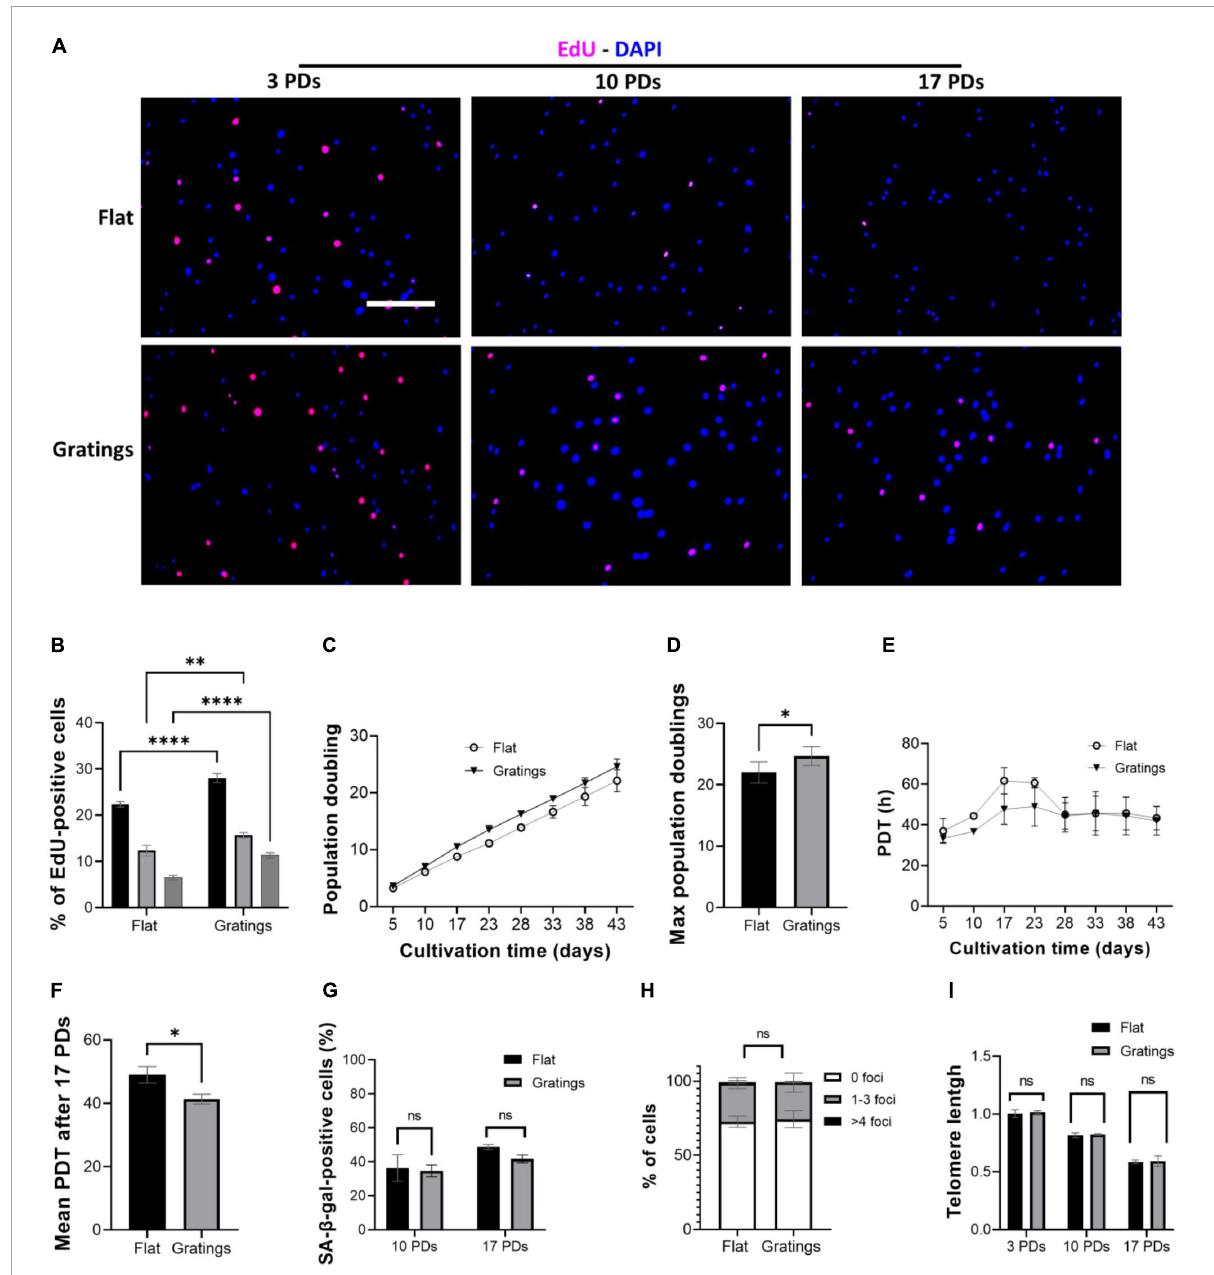
FIGURE6 Gratings increase HUVEC proliferation without inducing an early onset of senescence or DNA damage. (A) EdU proliferation assay with cells after 3, 10, and 17 PDs, which were cultured on a flat surface (upper panel) or on a surface with gratings (lower panel). Blue, DAPI; Red, EdU. Scale bar, 400 µ m. (B) Percentage of EdU-positive cells after 3, 10, and 17 PDs. (C) Cumulative growth curve during expansion of HUVECs isolated from three different umbilical cords on a flat surface and a micro-structured surface with gratings. (D) PDT of HUVECs during in vitro expansion on a flat surface and a micro-structured surface with gratings. (E) Maximum PDs achieved after cultivation on a flat surface or on a surface with gratings for a total period of 43 days. (F) Calculation of mean PDT after 17 PDs on a flat surface or on a surface with gratings. (G) Percentage of SA- β -gal-positive cells after 10 and 17 PDs on a flat surface or on a surface with gratings. (H) Percentage of cells presenting multiple γ -H2AX foci after 17 PDs on a flat surface or a surface with gratings. (I) Relative telomere length in relation to the number of PDs of HUVECs during in vitro expansion on a flat surface and a surface with gratings. Data represent the mean and standard error of the mean of 3 donors, for (A,B) more than 600 cells per condition, for (E) more than 2,500 cells per condition, for (F) more than 276 cells and for (G) more than 100,000 cells per condition were analyzed, ∗ p < 0.05; ∗∗ p ≤ 0.01; ∗∗∗∗ p ≤ 0.0001; ns, not